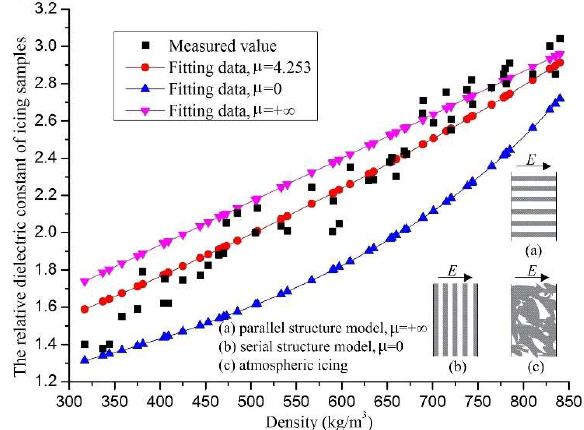
Sensors 2018 , 18 , x FOR PEER REVIEW 10 of 12 Figure 8. The relative dielectric constant of the icing samples with 4.253  . Figure 8. The relative dielectric constant of the icing samples with µ = 4.253.